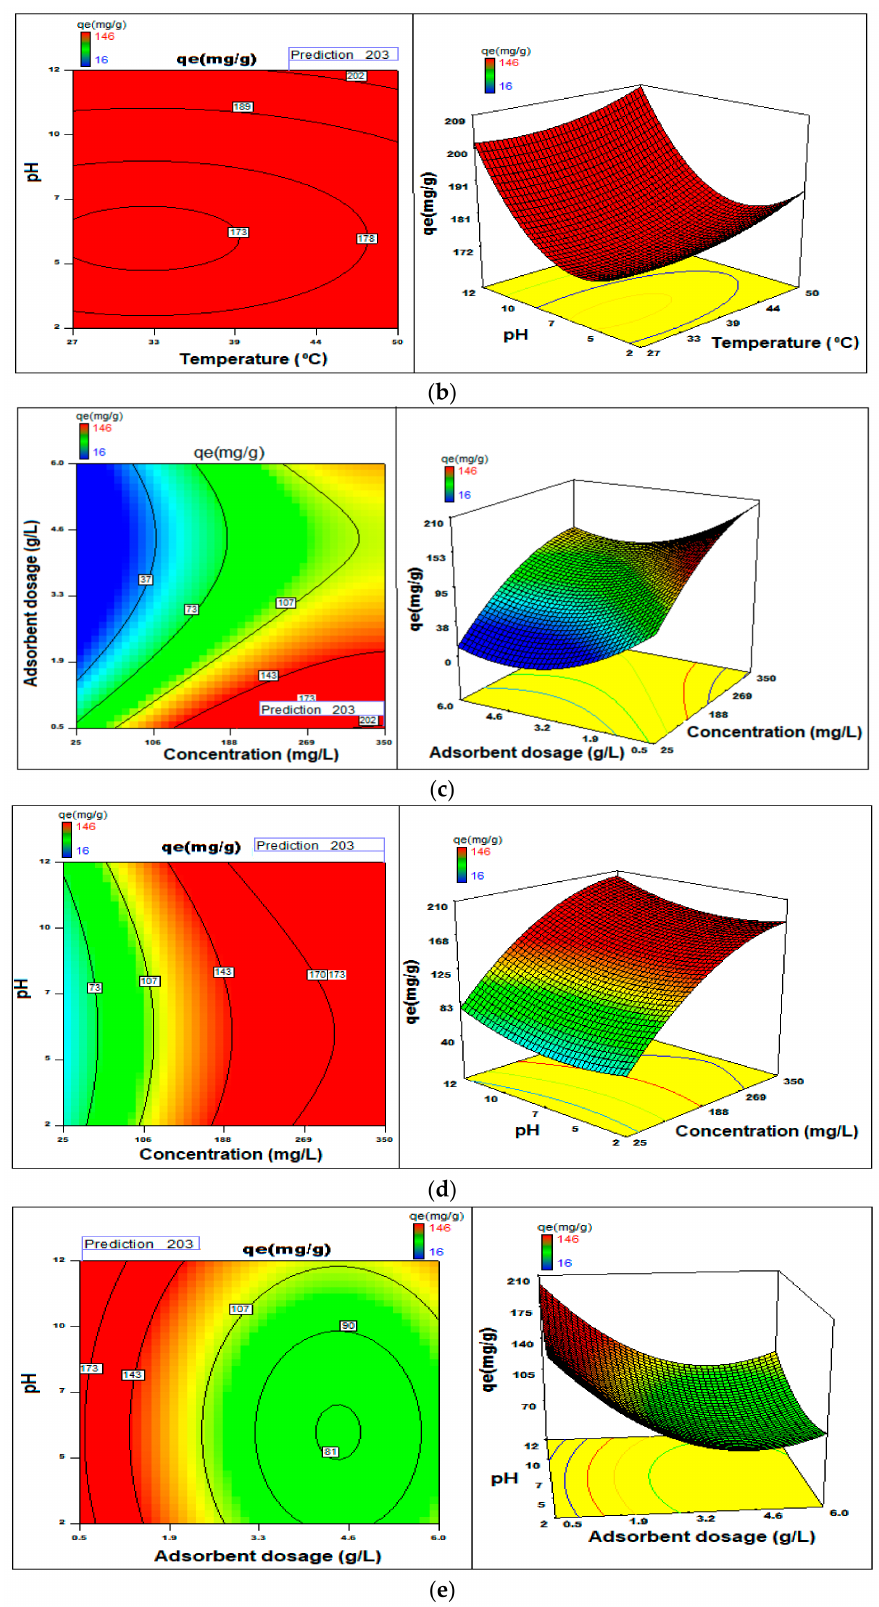
Figure 13. 3D surface plot and contour plot depicting the capacity variation of adsorption with ( a ) the temperature versus adsorbent dosage, ( b ) temperature versus pH, ( c ) concentration versus adsorbent dosage, ( d ) concentration versus pH, and ( e ) adsorbent dosage versus